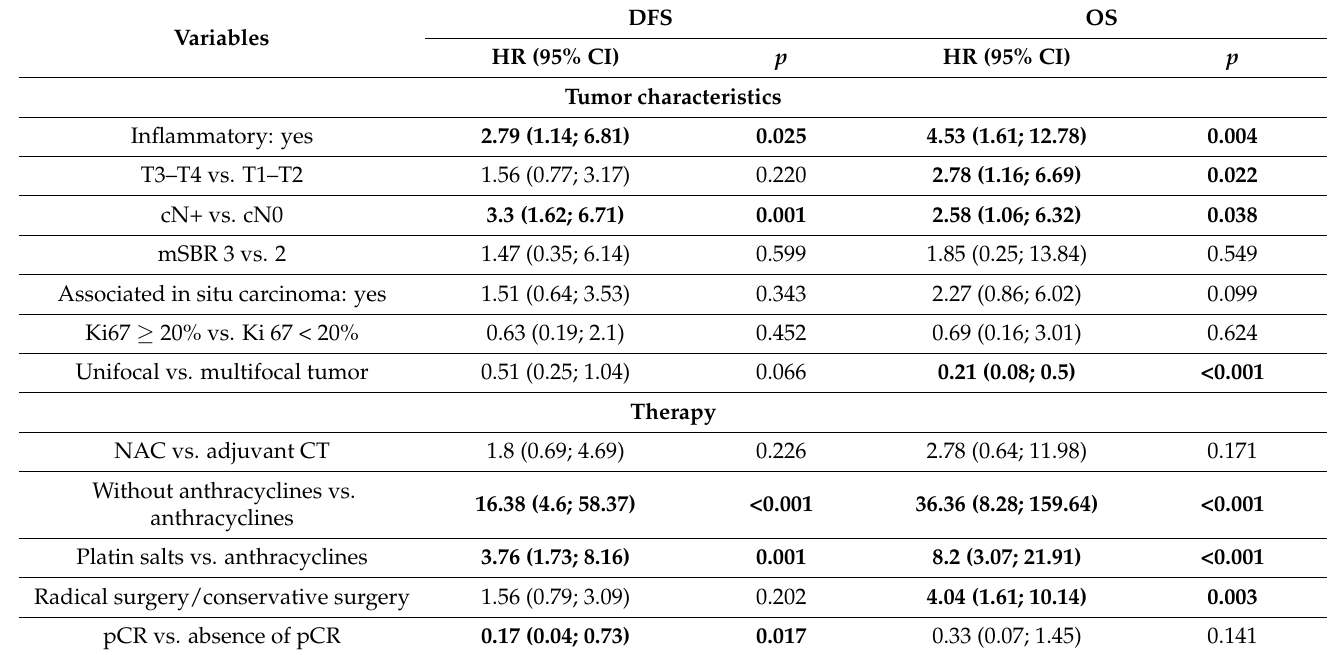
Table 4. Univariate analysis using a Cox model of clinical, histological and PET/CT parameters with DFS and OS for the 111 TNBC patients.